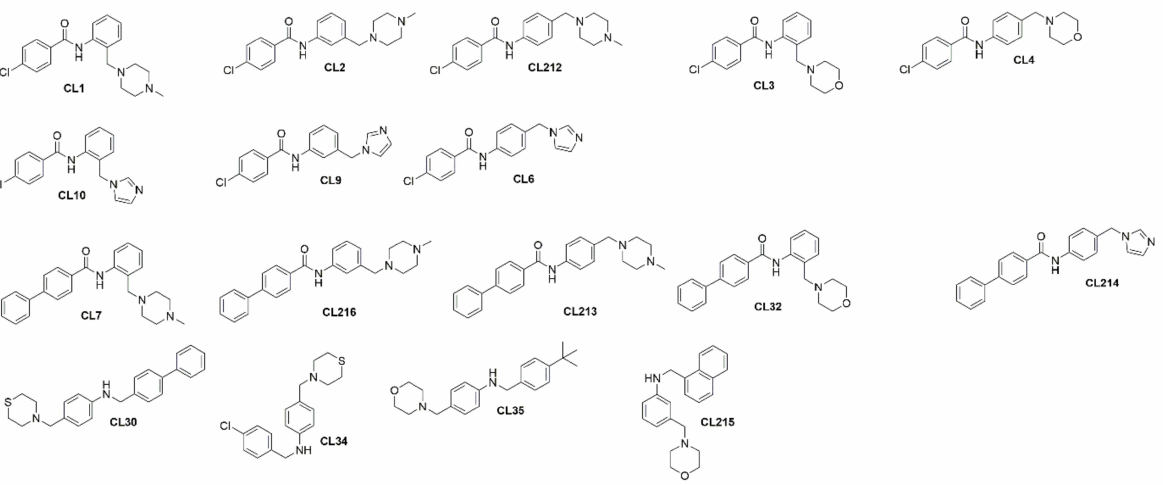
Figure 3. Chemical structures of CL212 and CL213